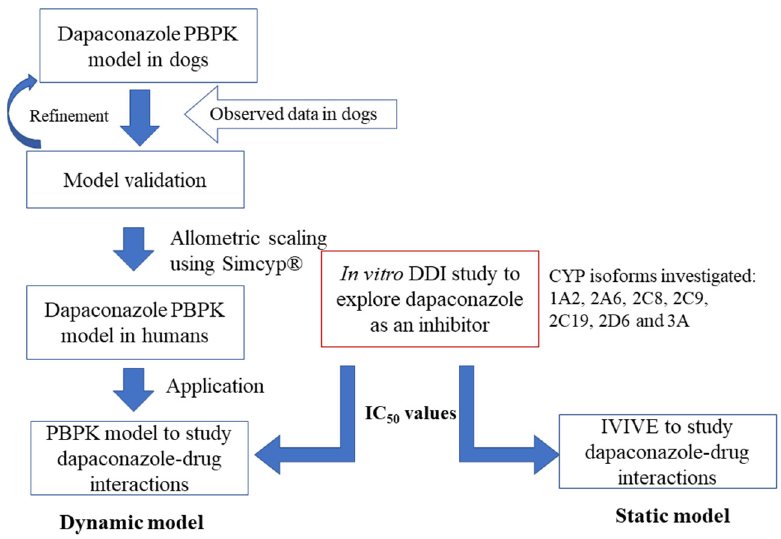
Figure 2. Study Figure 2. Study workflow.